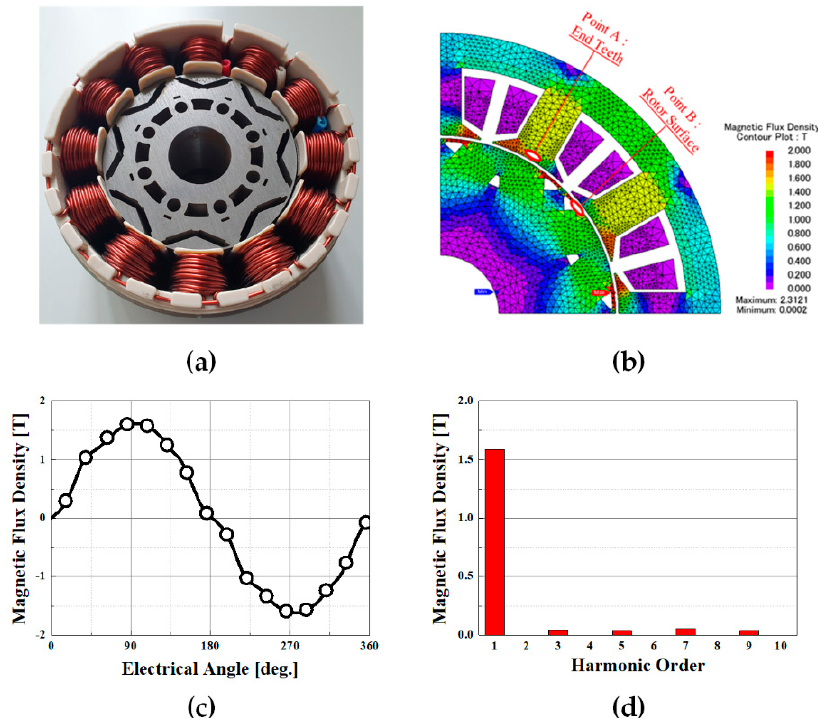
Figure 5. ( a ) Prototype sample picture of the automotive A/C refrigerant compressor IPMSM. ( b ) The distribution of magnetic flux density in the 2-D plane. ( c ) The magnetic flux density of point A in the time frame. ( d ) FFT analysis of the magnetic flux density in point A.